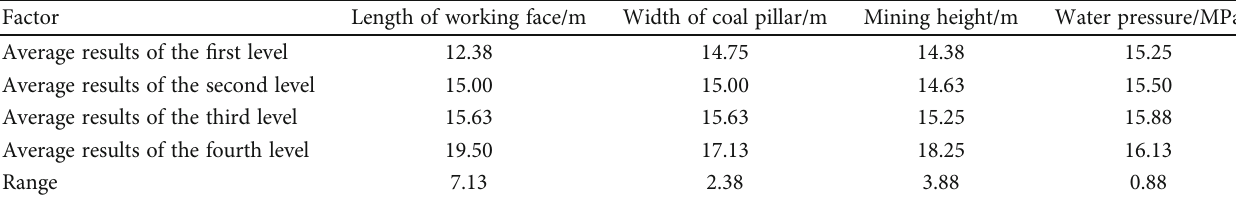
Table 3: Orthogonal experiment range analysis Tab. (plastic zone development height).